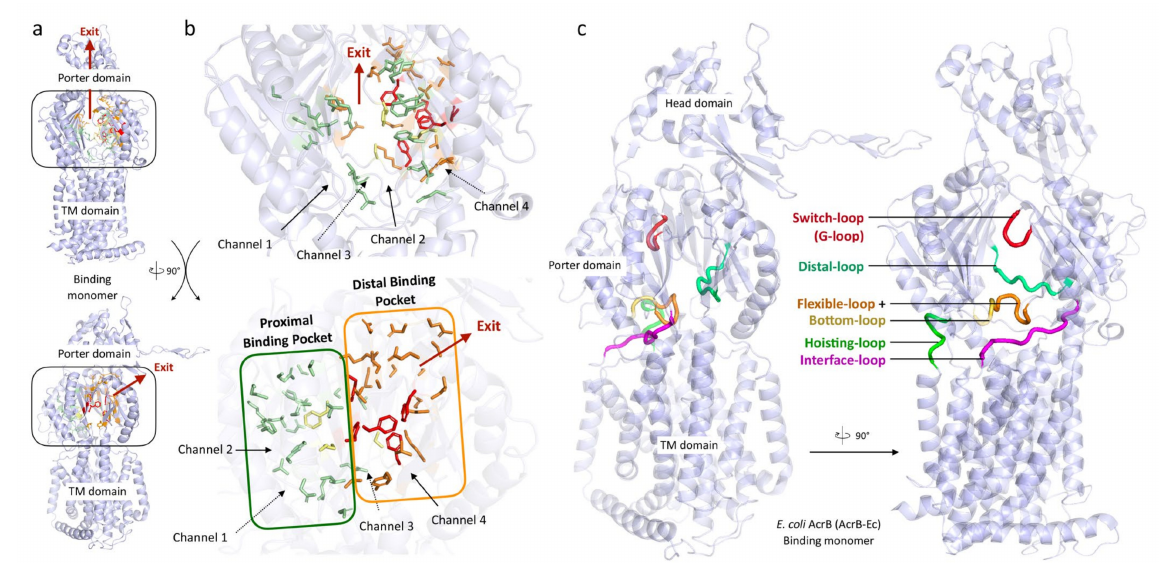
Figure 2. The structure, domains and loops of the RND monomers. ( a ) Side views of the entire protomer of AcrB-Ec. ( b ) The porter domain with the highlighted proximal (PBP) and distal binding pockets (DBP) and their drug-interacting residues. Arrows roughly indicate channels (dashed arrows indicate behind the image). Colors: orange, DBP; green, PBP; yellow, between DBP and PBP; red, Phe residues in the hydrophobic pit. ( c ) Side views of the flexible loops. The cartoon representation is transparent, allowing one to view all loops and residues in their entirety. PDB accession code 3W9H